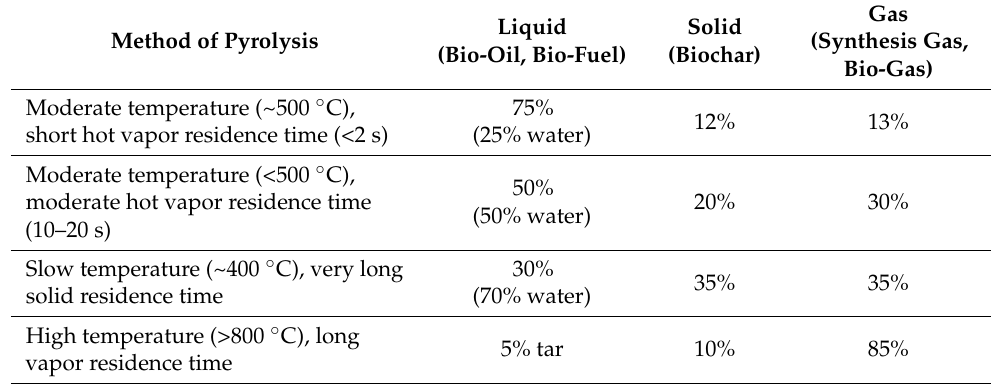
Table 2. The products of initial feedstock mass under selected pyrolysis conditions